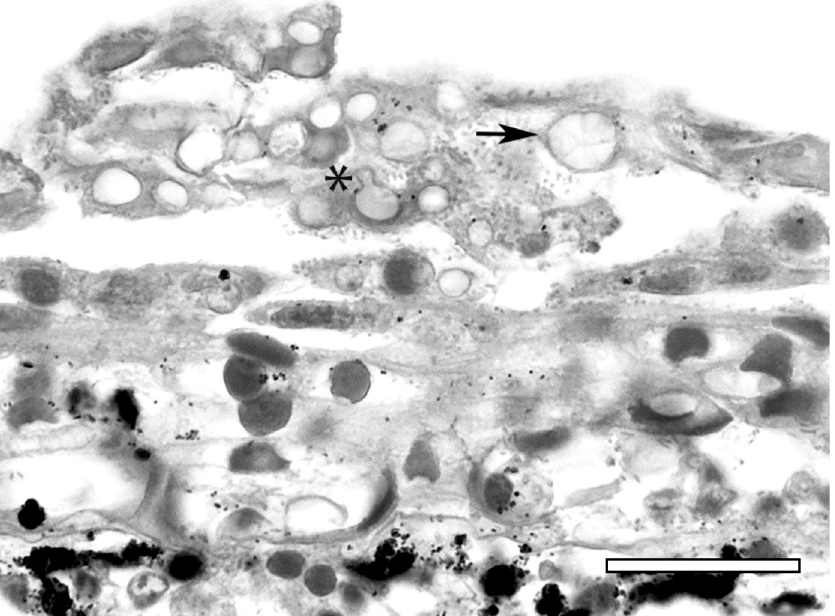
Fig 3. Histologic findings from a California red-legged frog ( Rana draytonii ) with chytridiomycosis. Marked hyperkeratosis with numerous empty chytrid fungal thalli. Characteristic thallus forms include zoosporangia with prominent discharge tubes (asterisk) and internally septate colonial thalli (arrow). Bar = 30 microns.